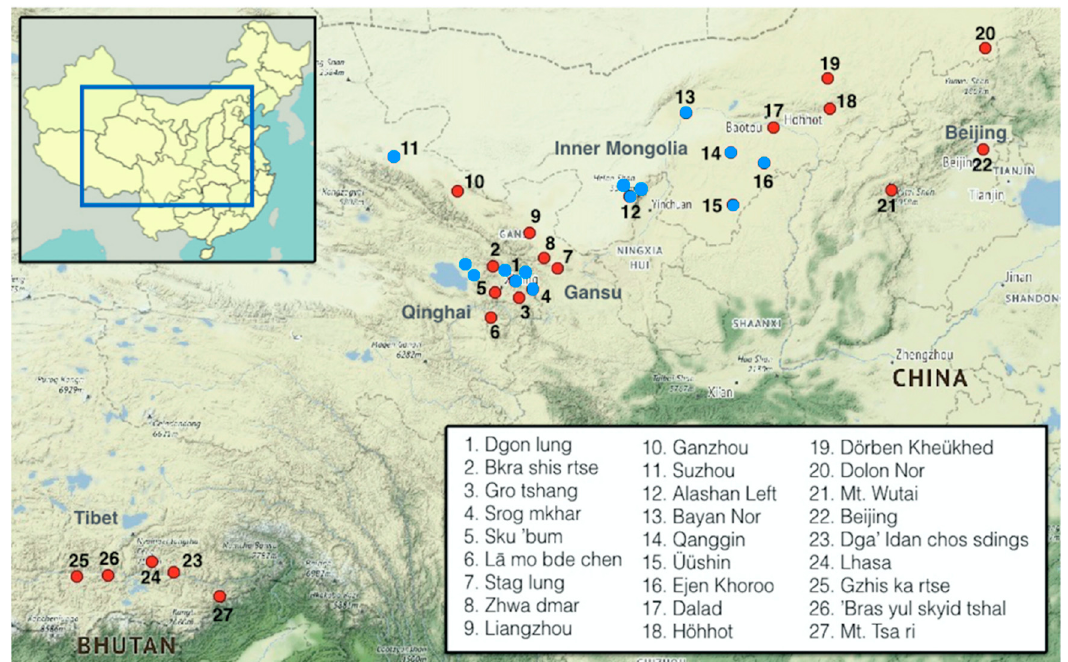
Figure 1. Main sites of Sumpa Khenpo’s activities. Blue dots indicate the sites where Sumpa Khenpo performed his rainmaking rituals. Generated by QGIS 2.18 (© Hanung Kim).